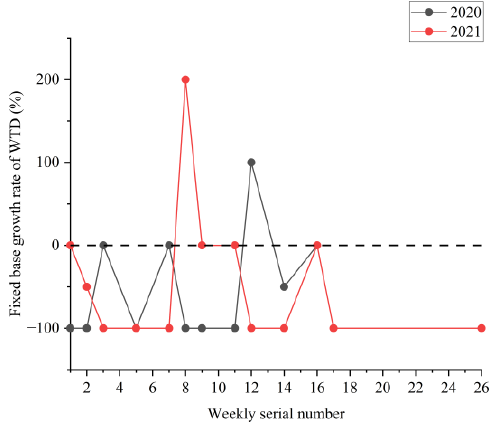
Figure 13. Fixed base growth rate of WTD.